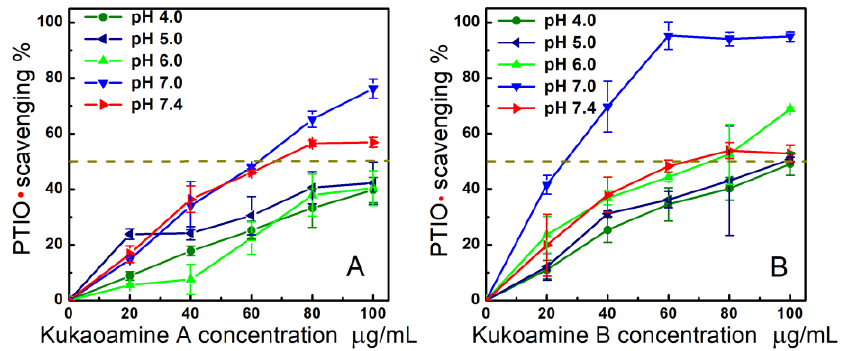
Figure 3. Concentration-response curves for kukoamine A and B in PTIO• scavenging at various pH values (pH 4.0, 5.0, 6.0, 7.0, and 7.4) (Trolox concentration response was measured only at pH 7.4 as a positive control. The concentration-response curves of Trolox are shown in Supplementary 1. Each value is expressed as the mean ± SD, n = 3; The IC 50 values were detailed in Table 1).